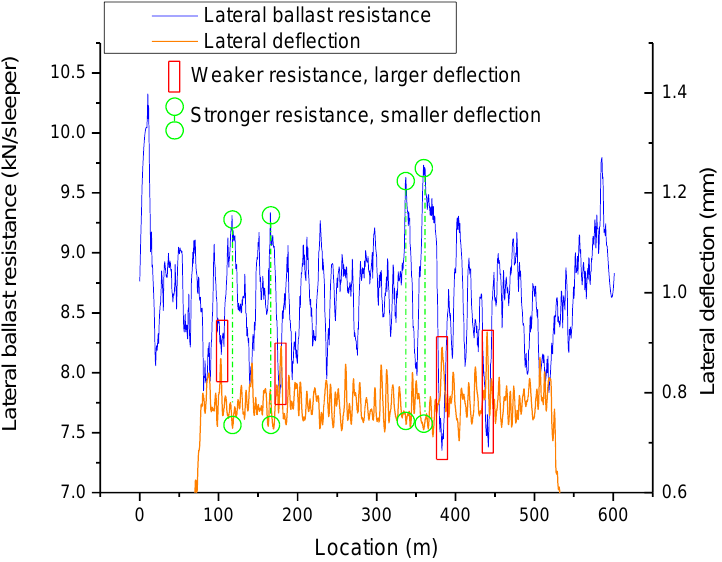
Figure 14. Smoothed lateral ballast resistance versus the lateral deformation along the track. When temperature increases, a thermal axial force is produced inside the rail. Figure 15 illustrates the distribution of the thermal axial force at 50 ◦ C above the neutral temperature.